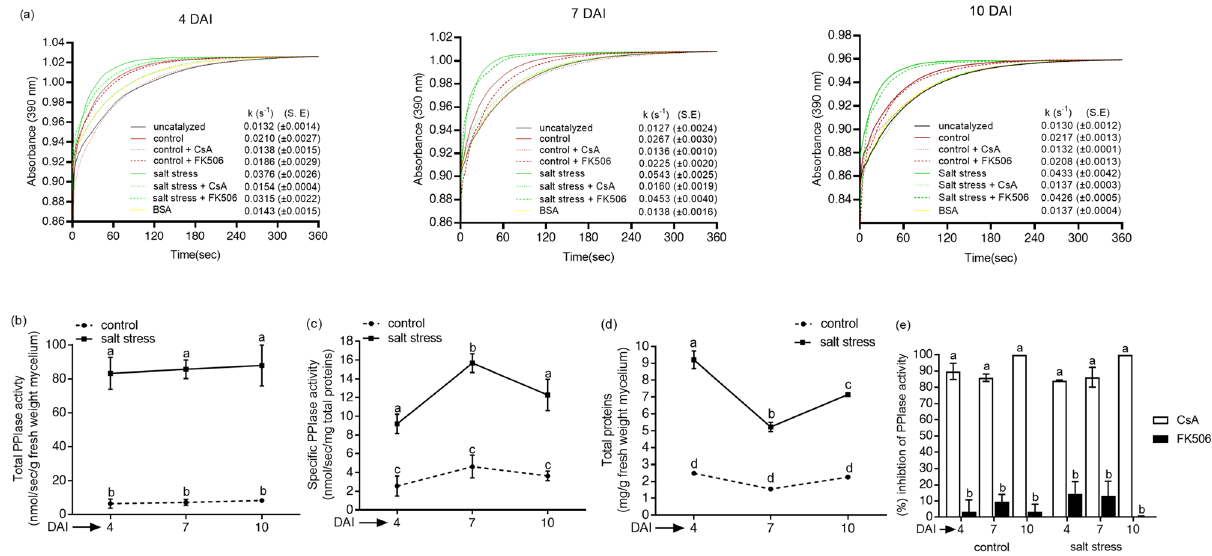
Figure 4. (a) Representative spectra showing the effect of salt stress (15% NaCl) on the mycelial peptidyl- prolyl cis–trans isomerase (PPIase) activity of Penicillium oxalicum at 4, 7 and 10 days after inoculation (DAI). The PPIase activity in the crude mycelial extracts was estimated by studying the rate of chymotrypsin catalyzed cleavage of the test peptide, and expressed as the first-order rate constant, k (s –1 ). Higher first-order rate constant signified greater PPIase activity in the extract. 20 μg of total proteins was used for this assay, with bovine serum albumin (BSA) as a negative control. The cyclophilin- and FK506-binding protein (FKBP)-associated PPIase activity was estimated by the extent of inhibition in the presence of 100 nM cyclosporin A (CsA) and 2 μM FK506, respectively. Control refers to the cultures grown in Sabouraud medium without supplementing with NaCl. ( b) Changes in the total PPIase activity (nmol/sec/g fresh weight mycelium) and (c) specific PPIase activity (nmol/sec/mg total proteins), and (d) total soluble proteins (mg/g fresh weight mycelium) in the mycelia of Penicillium oxalicum grown in the presence or absence of salt. (e) Effect of specific inhibitors of cyclophilins (CsA) and FKBPs (FK506) on mycelial PPIase activity. The percent inhibition of PPIase activity is expressed with respect to the uninhibited control. The values depict the mean of three biological replicates ± standard error and are significant at P ≤ 0.001 (Tukey-HSD test; α = 0.05). The values with distinct letters are significantly different. (DAI: days after